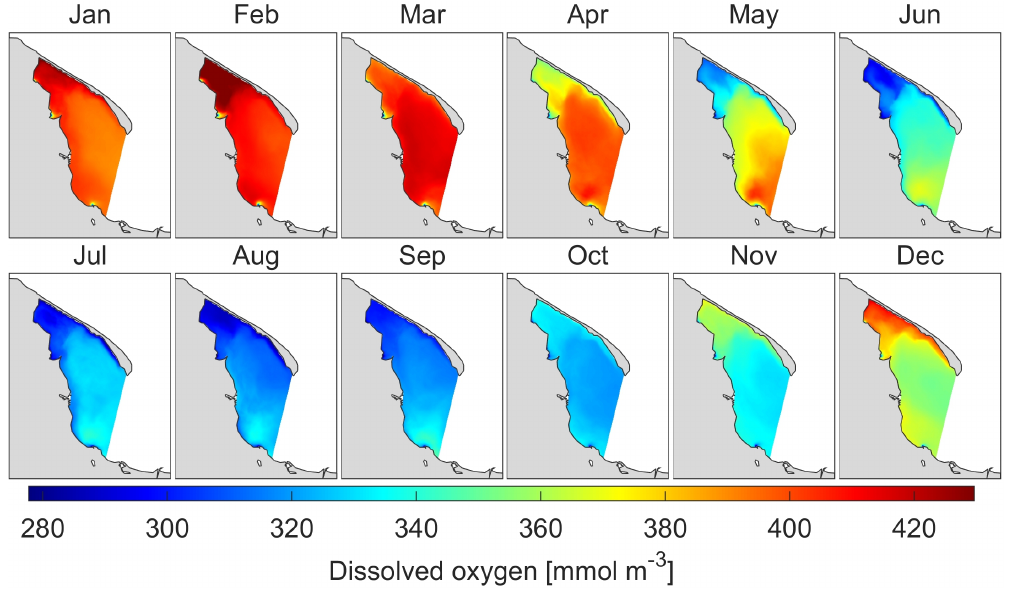
Figure 7. Monthly means of dissolved oxygen concentration at sea